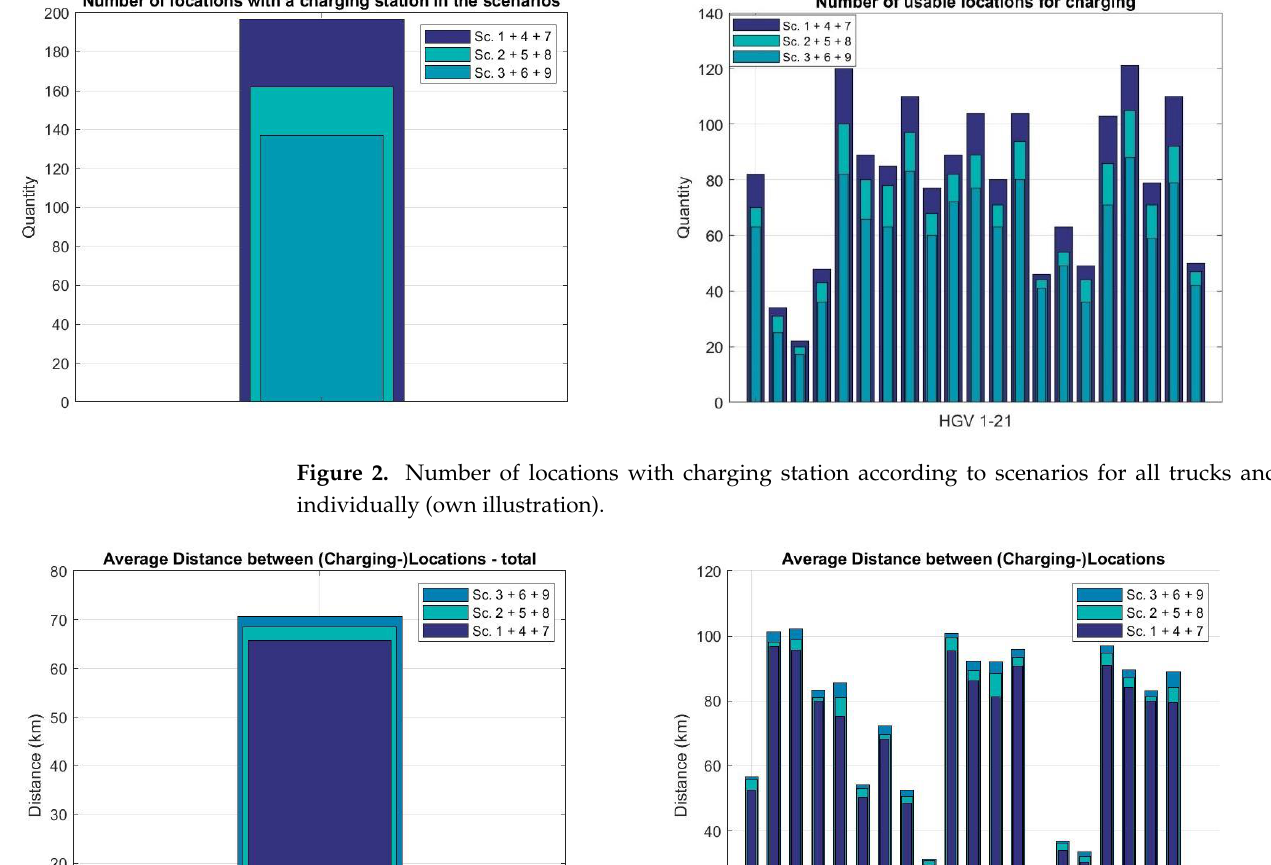
Figure 2. Number of locations with charging station according to scenarios for all trucks and indi- vidually (own illustration).